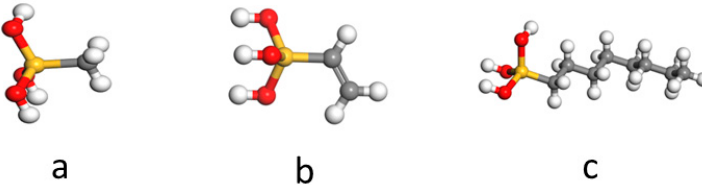
Figure 10. The molecular structures of ( a ) methyltriethoxysilane (MTES), ( b ) vinyltriethoxysilane (VTEO), and ( c ) octyltriethoxysilane.